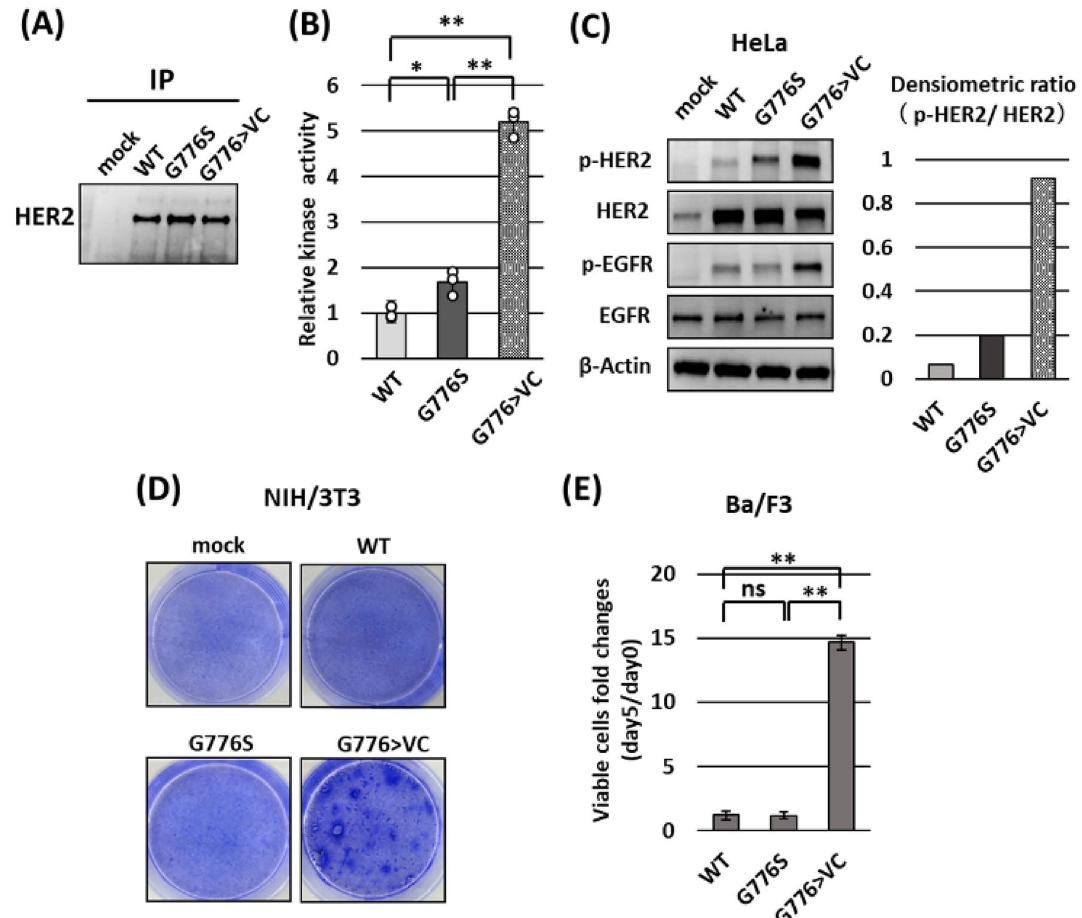
Figure 2. Effects of HER2 mutations on kinase activity and phosphorylation, and their functional evaluation in classical cell-based transfection assays. ( A ) Western blot results showing recombinant proteins of HER2 WT and mutants (G776S and G776 > VC). HeLa cells were transiently transfected with the HER2 expression vectors, and 48 h after the transfection, the cells were lysed and purified by immunoprecipitation using HER2 antibody. ( B ) Measurement of the kinase activity of 100 ng of recombinant HER2 protein using the kinase assay. Kinase activity was measured in triplicate, and the data were standardized to the mean HER2 WT activity. One-way ANOVA: P < 0.01, * P < 0.05, ** P < 0.01. ( C ) Western blot results for the expression and phosphorylation of HER2 and EGFR in HeLa cells transfected with the HER2 expression vectors. β-Actin served as an internal control. The bar graph indicates the normalized ratios of densitometric values of phosphorylated to total HER2 protein. ( D ) Focus formation assays using NIH/3T3 cells stably transfected with the indicated plasmids. ( E ) Ba/F3 transformation assays using Ba/F3 (interleukin 3-dependent cells) stably transfected with the indicated plasmids. The bar graph shows the fold changes in number of viable cells. ns, not significant. One-way ANOVA: P < 0.01, ** P < 0.01 ( n =